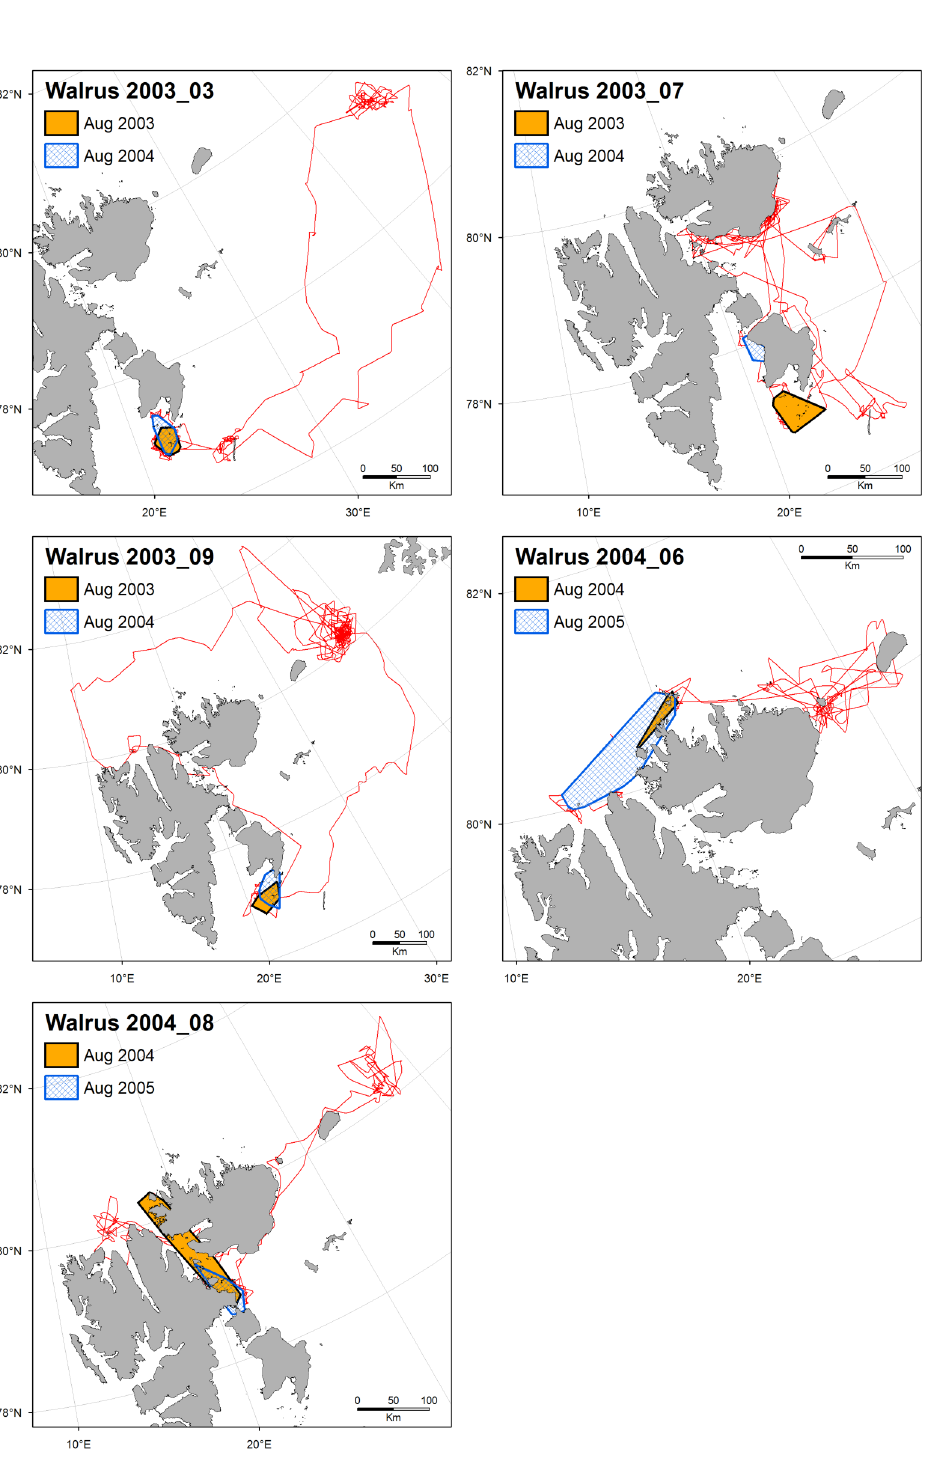
Fig 5. Home ranges (100% minimum convex polygons) used by five walruses for which data were available for the month they were tagged (August 2003 or August 2004) and for August the following year. The complete tracks for these animals are also presented. (From Freitas et al.